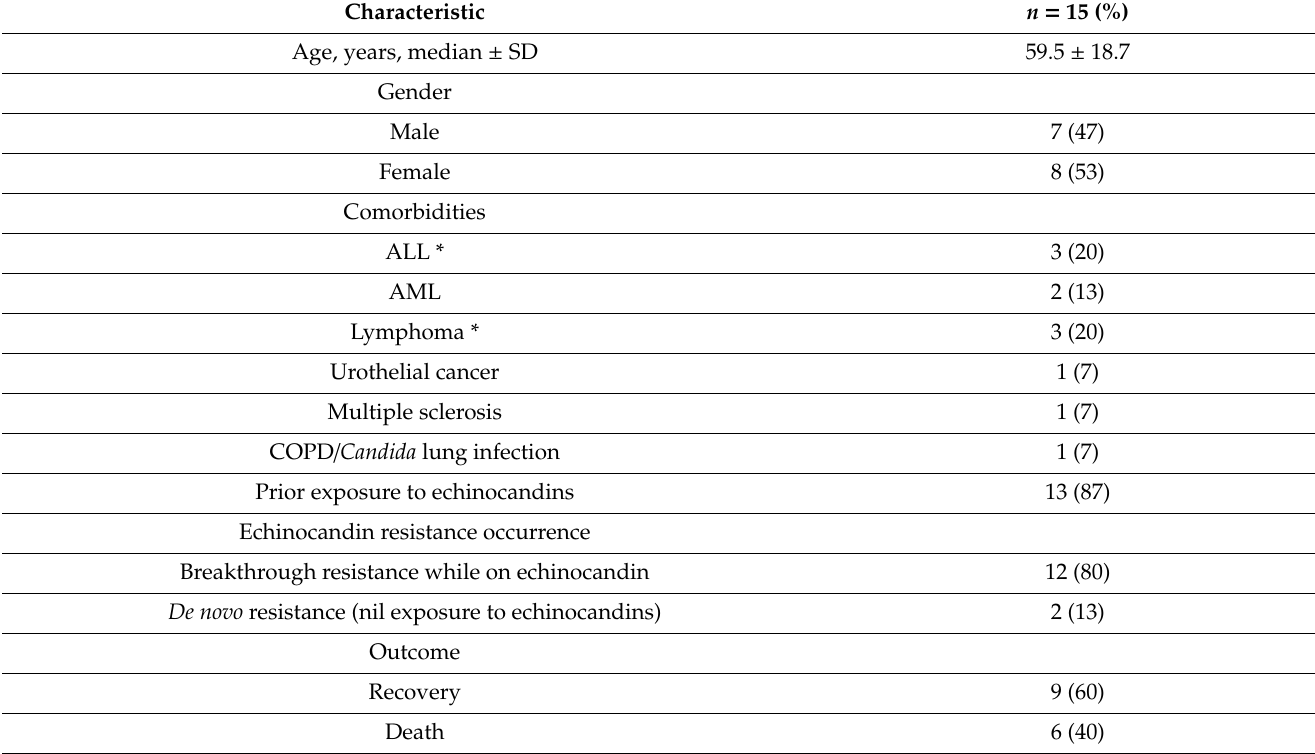
Table 3. Demographics and clinical characteristics of patients with echinocandin-resistant Candida tropicalis bloodstream